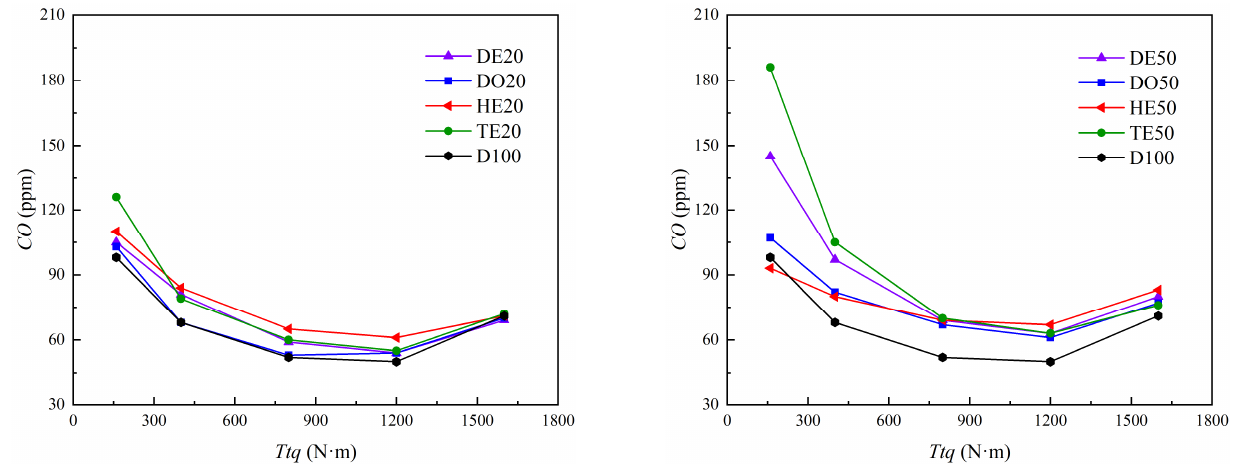
Figure 15. CO emissions versus engine loads at 1900 rpm.